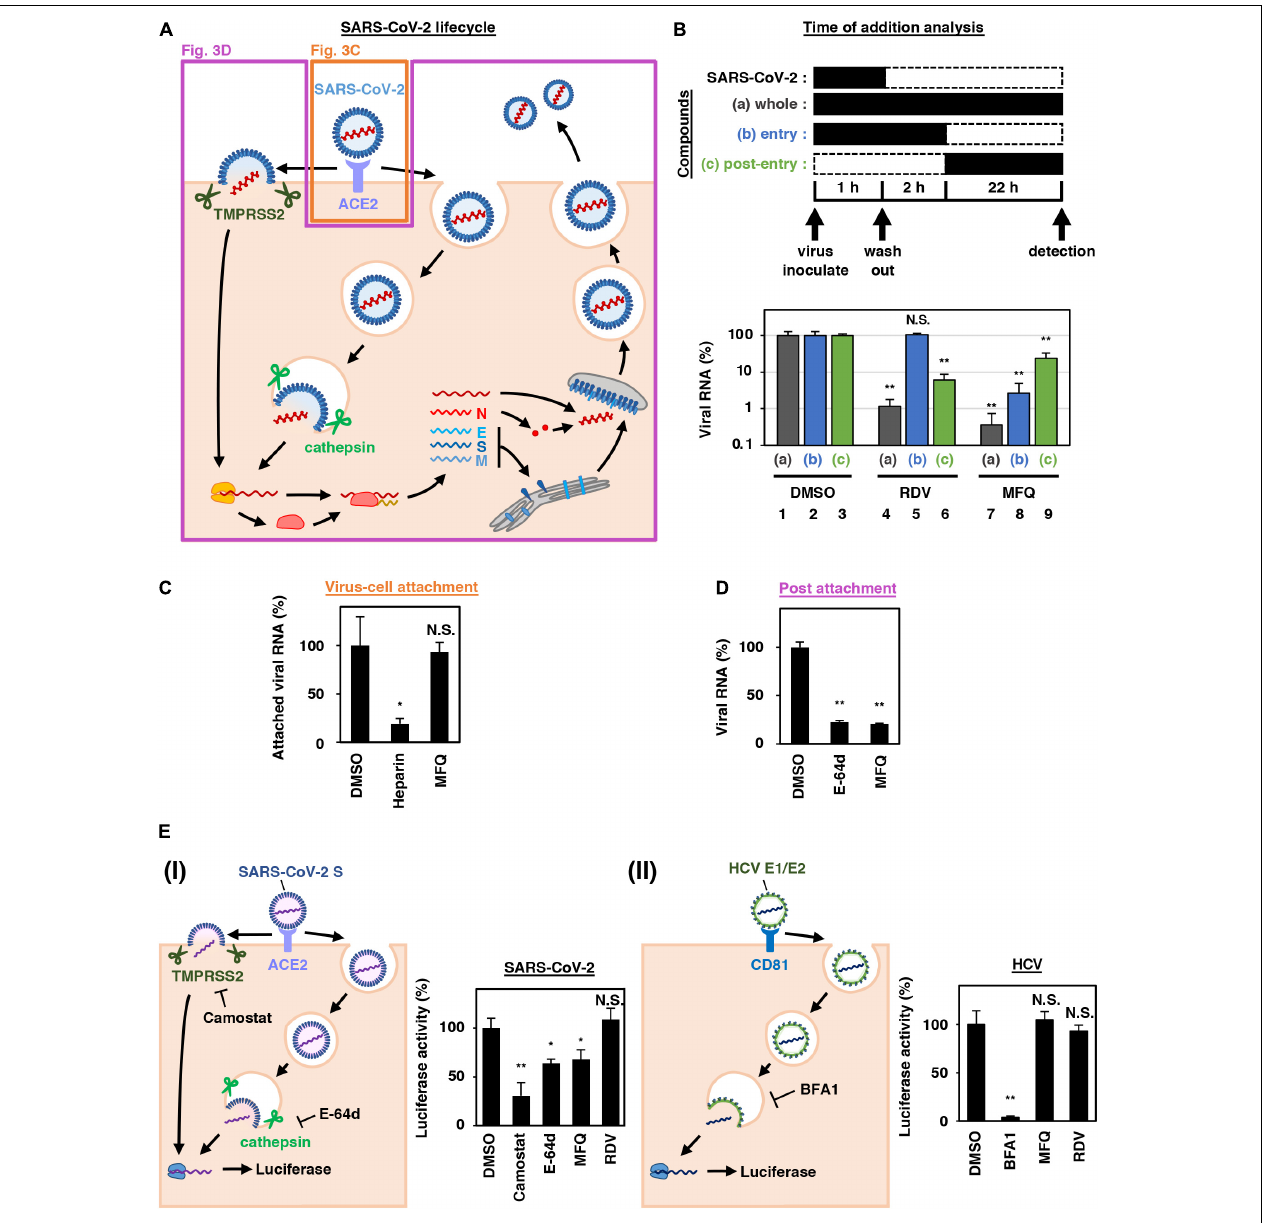
FIGURE 3 | MFQ inhibits the SARS-CoV-2 entry process. (A) SARS-CoV-2 life cycle. SARS-CoV-2 infection is initiated with virus attachment to the host cells that involves the cellular receptor, angiotensin converting enzyme 2 (ACE2), followed by the cleavage of viral Spike (S) proteins by either transmembrane serine protease (TMPRSS2) on the plasma membrane or cathepsins in the endosome/lysosome that induces fusion of viral and host membranes. Viral RNA is translated, processed and replicated to be assembled into progeny virus with viral structural proteins and released extracellularly. (B) Scheme of the time of addition analysis. Compounds were treated at three different times: (a) whole: throughout the assay for 25 h, (b) entry: for the initial 3 h to evaluate the effect on the viral entry process and (c) post-entry: for the last 22 h to evaluate the effect on viral replication/re-infection. Viral RNA levels in the culture supernatant are shown in the graph by setting that upon DMSO treatment as 100%. (C) Virus-cell attachment assay. VeroE6/TMPRSS2 cells were exposed to virus at an MOI of 0.001 at 4 ◦ C for 5 min with 50 µ M MFQ or 100 U/mL Heparin, a SARS-CoV-2 attachment inhibitor used as a positive control. After washing the unbound virus, cell surface-attached virus was extracted and quantified by real-time RT-PCR. (D) Post-attachment assay. For evaluating the activity after virus attachment, from membrane fusion to virus secretion, VeroE6/TMPRSS2 cells preincubated with the virus at an MOI of 1.5 at 4 ◦ C for 1 h to allow virus attachment were treated with compounds for 6 h at 37 ◦ C. Extracellular viral RNA was quantified by RT-qPCR. E-64d, a cysteine protease inhibitor, was used as a positive control. (E) Pseudovirus assays carrying the SARS-CoV-2 Spike or hepatitis C virus (HCV) E1E2 envelope. In the SARS-CoV-2 pseudovirus assay, Camostat and E-64d were used as positive controls for inhibiting TMPRSS2 and cysteine protease, respectively ( E , left). Bafilomycin A1 (BFA1), which reported to inhibit HCV entry, was used as a positive control for HCV pseudovirus assay ( E , right). * p < 0.05 and ** p <